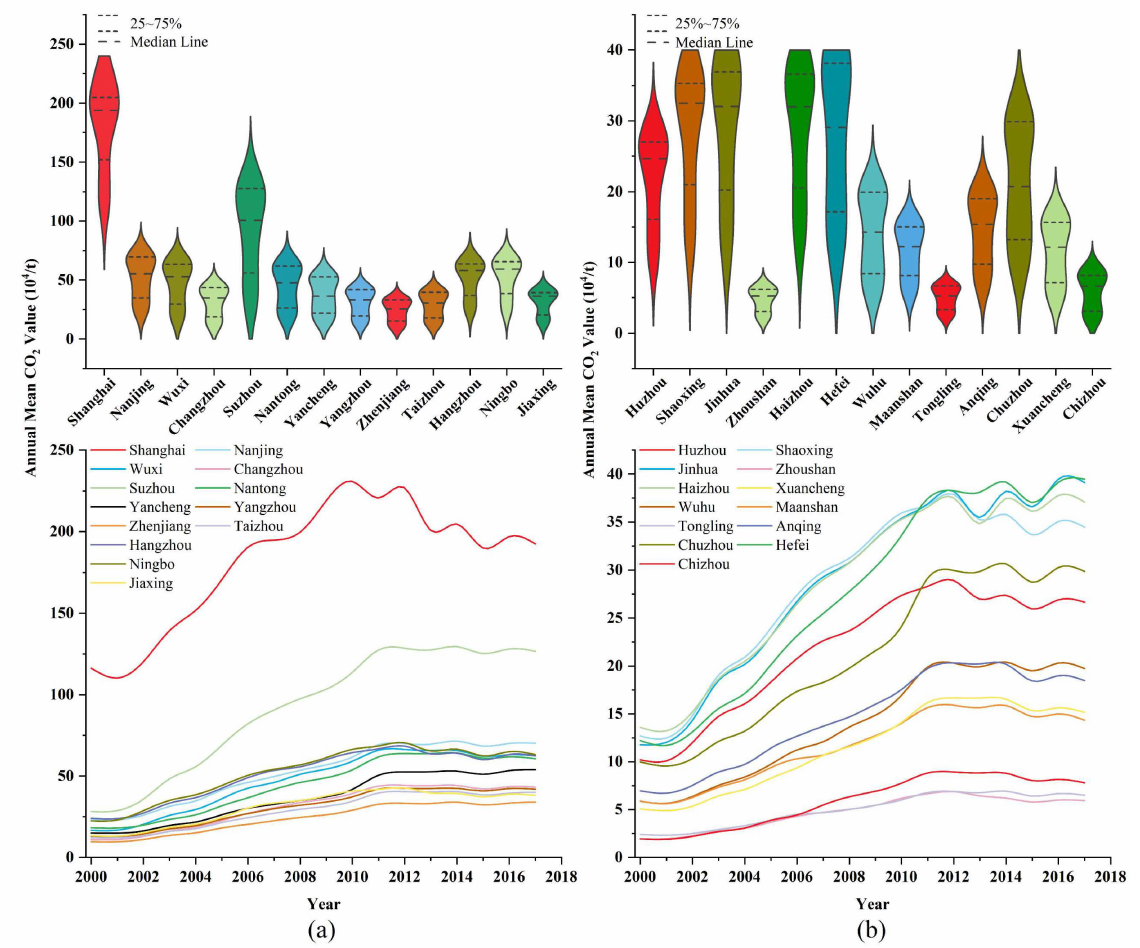
Figure 5. Trend and distribution of CO 2 emission in cities from 2000 to 2017. ( a ) Shanghai and other cities, ( b ) Huzhou and other